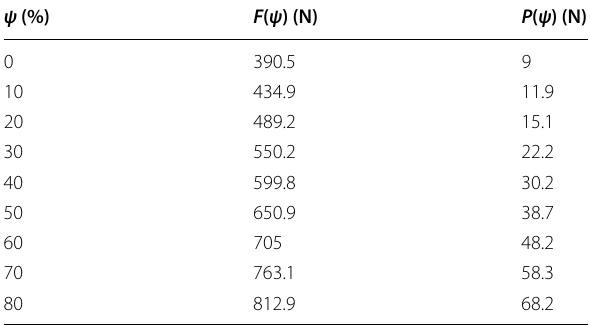
Table 6 Value of P ( ψ ) and F ( ψ ) in the case of different material filling rate